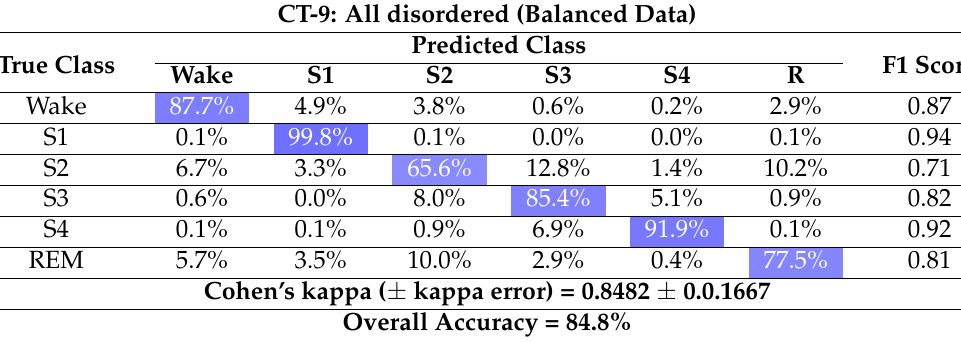
Table 26. Confusion matrix corresponding to sleep stage classification of all disordered patients with balanced data using the EBT classifier with 10-fold